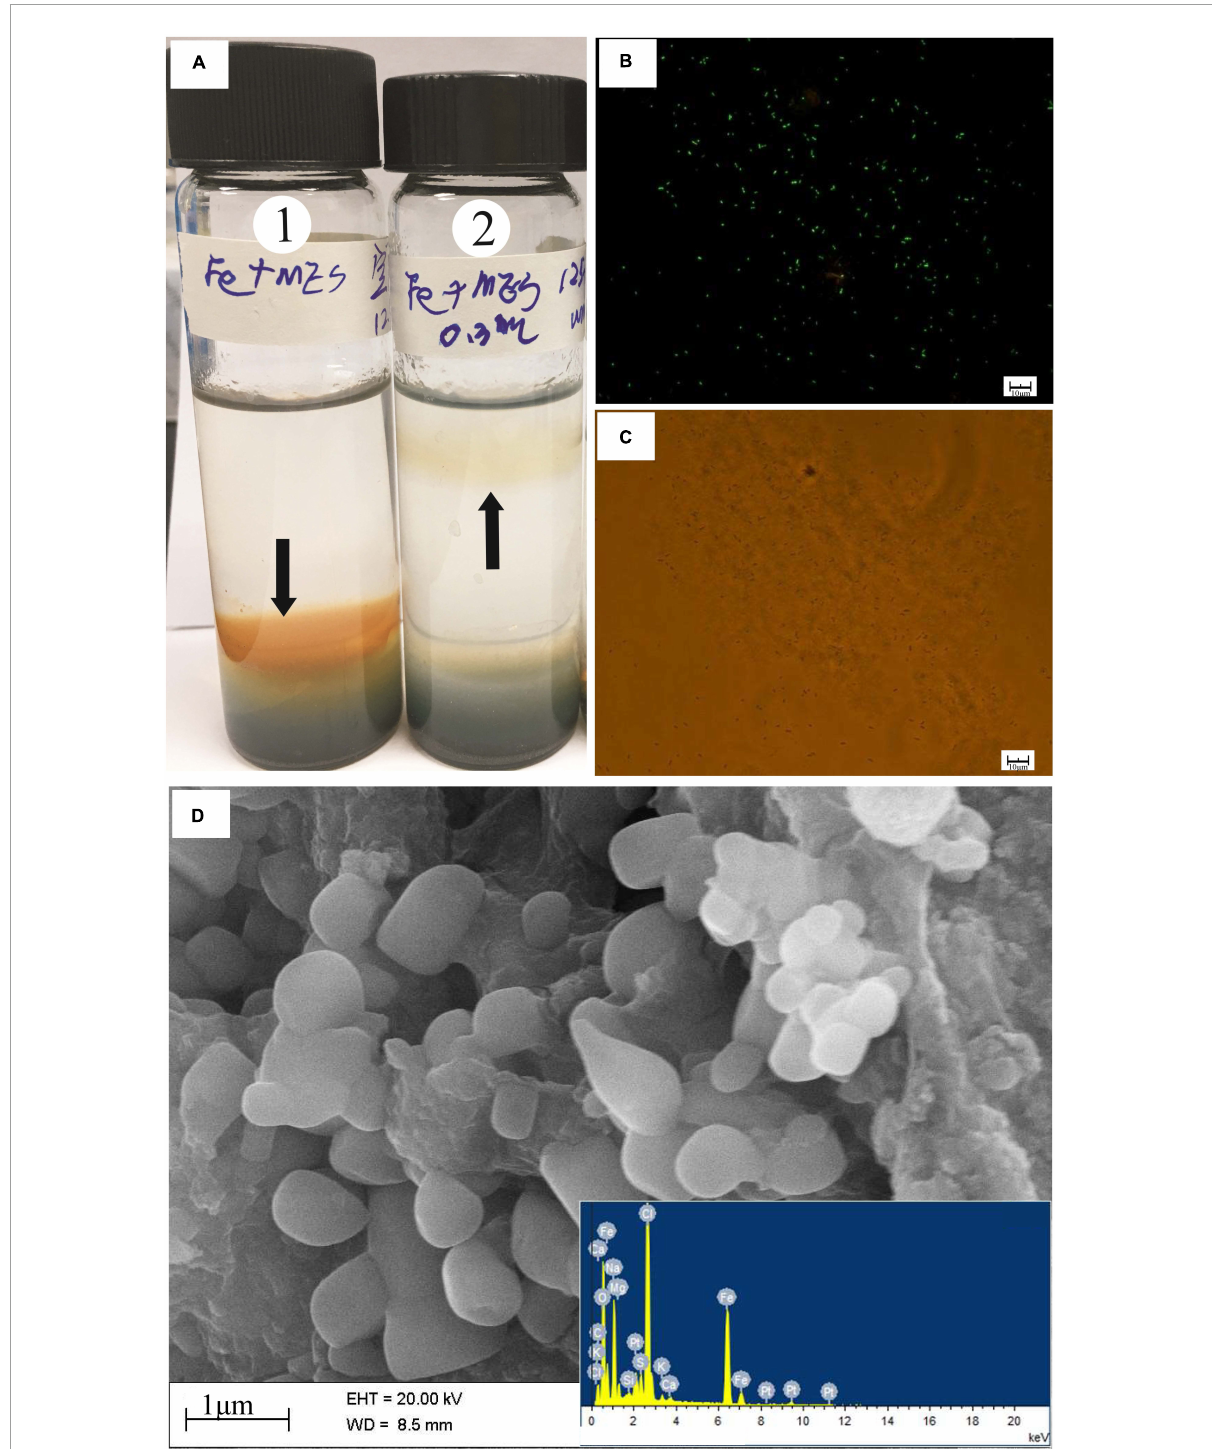
FIGURE5 (A) O 2 /ZVI gradient tubes incubated for 14 days at 28 ◦ C. Tube 1 is an uninoculated control; tube 2 is inoculated with 0.3 ml of strain MM120-6. In the culture tube, discrete bands of microbes growth ∼ 1.5 cm off from gas-medium interface at the top of the tube. Black arrows indicate the position of the microbe growth region and iron oxides in the tubes. The milky band contains abundant cells observed by microscopy in fluorescent and brightfield (B,C) . SEM and EDS images of iron oxides band in the biotic experiment (D) . In the abiotic control, iron oxides develop at ∼ 0.3 cm above the top-bottom medium interface at the top. The SEM observation was performed at 20 kV with a working distance of 8.5 mm. Scale bar: (B,C) 10 µ m; (D) 1 µ